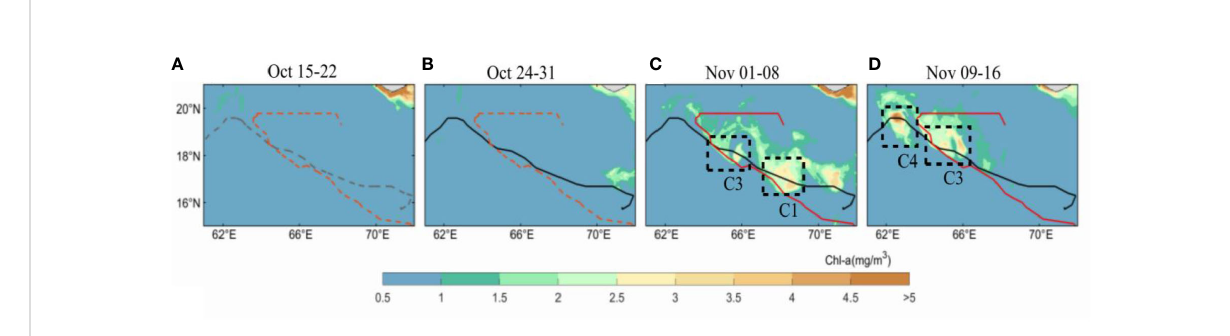
FIGURE 6 Observations of the 8-day mean chl-a concentration (mg/m 3 ) before, during and after Kyarr and Maha. (A) : before Kyarr, (B) : during Kyarr, (C) : after Kyarr and during Maha, and (D) : after Kyarr and Maha. The expression of the TC tracks is the same as that in Figure 4. The black boxes represent three typical regions with obvious chl-a increases and sea surface cooling, as shown in Figure